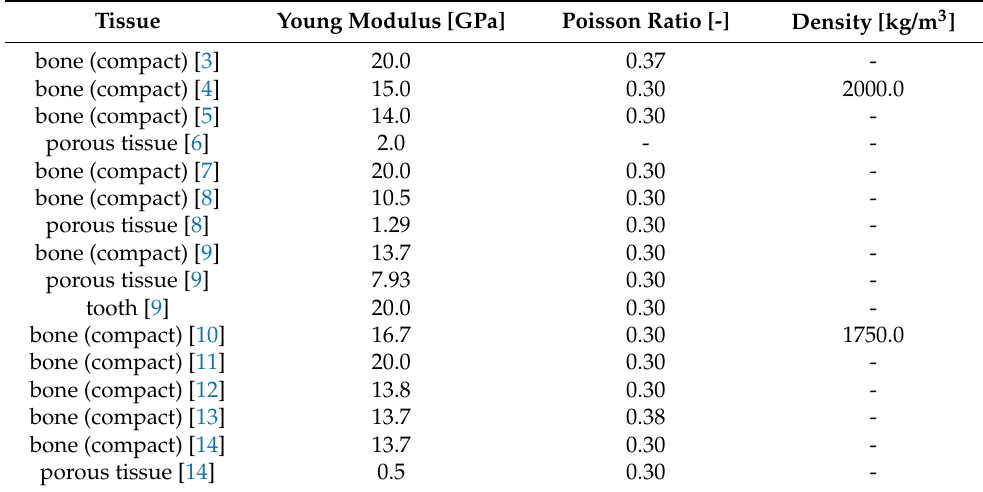
Table 1. Comparison of mechanical properties of human bones